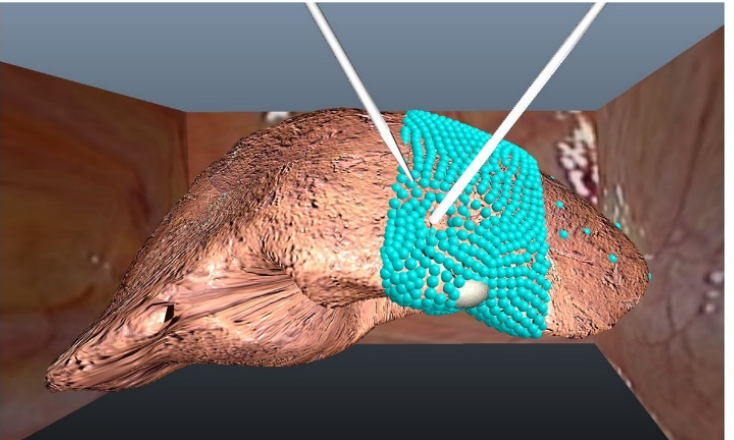
Figure 2. Liver model. This view shows the entire liver as modeled, with the particles in the tetrahedral mesh visible (they are not shown during the simulation). The single metastatic lesion is at the inferior edge of the left medial segment shown as a solid sphere. The area shown as particles is deformable when acted upon by either of the two instruments shown.